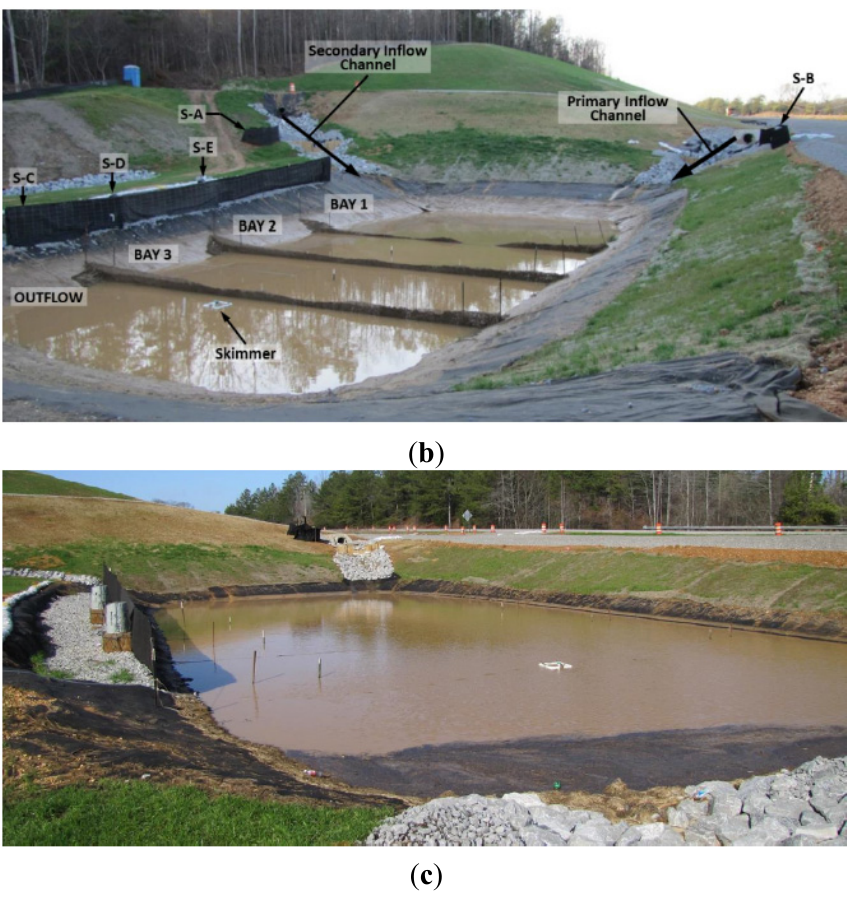
Figure 2. ( a ) Plan view (schematic diagram) and ( b ) a photo of actual project sediment